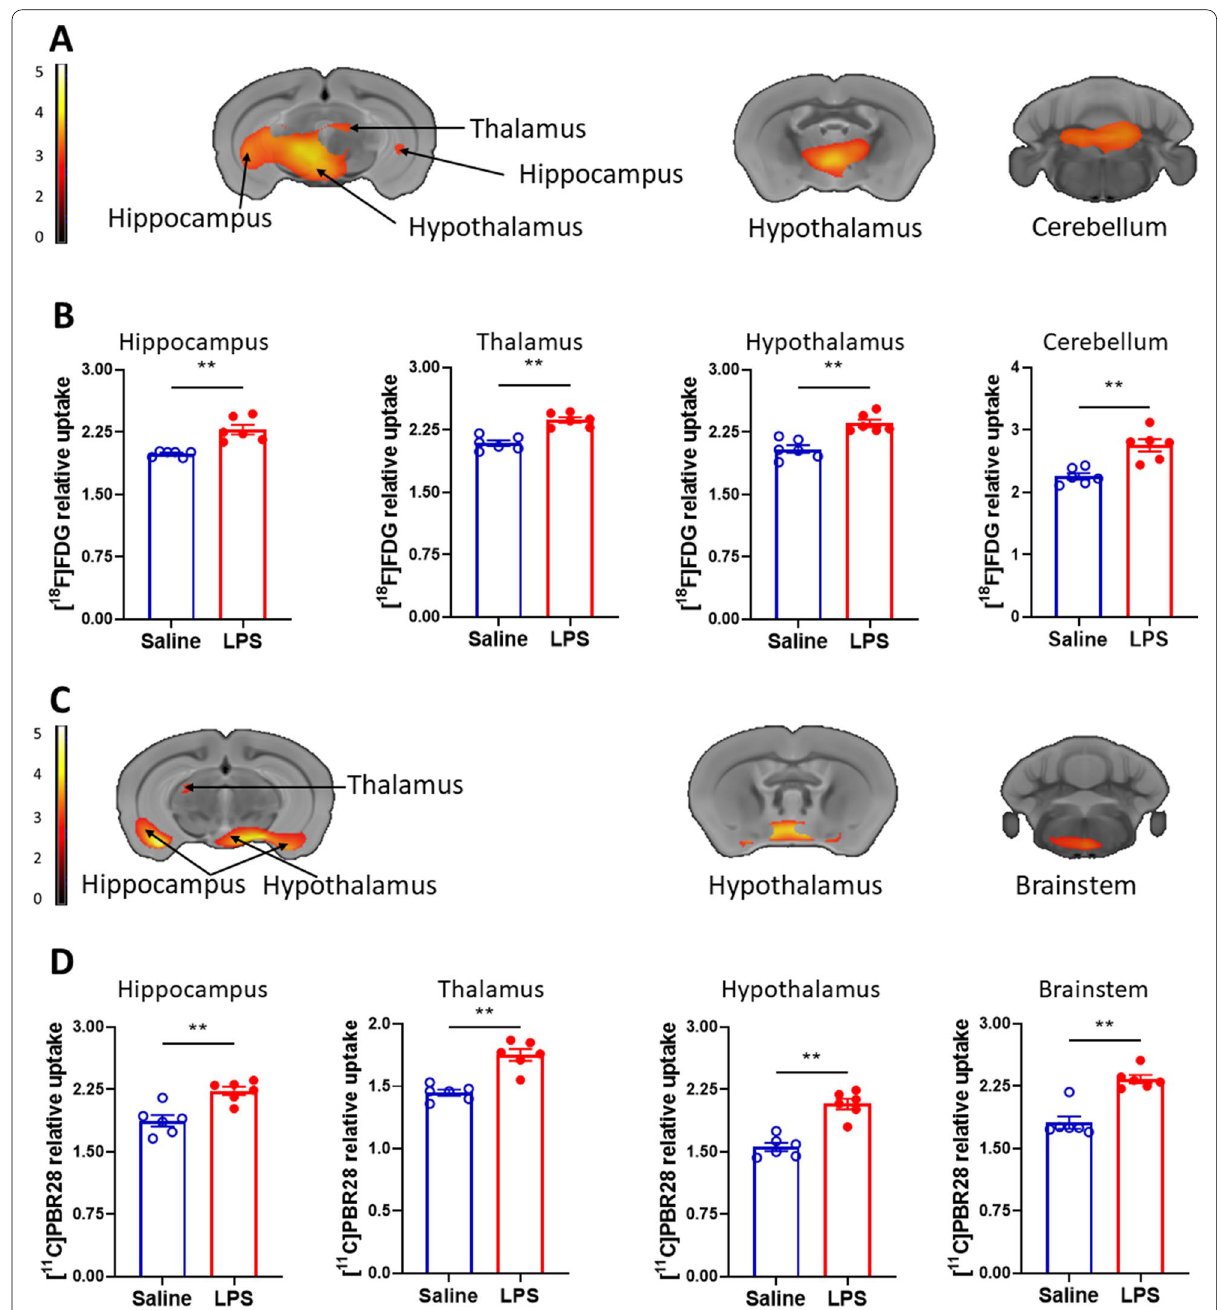
Fig. 2 Brain regions with individual increases in [ 11 C]PBR28 and [ 18 F]FDG uptake during endotoxemia. A Increased [ 18 F]FDG uptake in the hippocampus, the thalamus, the hypothalamus, and the cerebellum shown in coronal sections in LPS administered ( n 6) vs saline administered = ( n 6) mice (see Table 1 for specific stereotaxic coordinates). SPM clusters (color bar represents t‑value height, cutoff threshold T 3.55) overlaid = = onto MRI atlas for visualization. Statistically significant clusters ( P < 0.001). B Post‑hoc analysis of [ 18 F]FDG tracer uptake in the same groups (saline, n 6 and LPS, n 6) of mice. ** P 0.002. C Increased [ 11 C]PBR28 metabolic activity in the hippocampus, the thalamus, the hypothalamus, and = = = the brainstem shown in coronal sections in LPS administered ( n 6) vs saline administered ( n 6) mice (see Table 1 for stereotaxic coordinates). = = SPM clusters (color bar represents t‑value height, cutoff threshold T 3.55). Statistically significant clusters ( P < 0.001) overlaid onto MRI atlas = for visualization. D Post‑hoc analysis of [ 11 C]PBR28 uptake in the same groups (saline, n 6 and LPS, n 6) of mice. ** P 0.002, ** P 0.004 = = = = (hippocampus). See Methods for